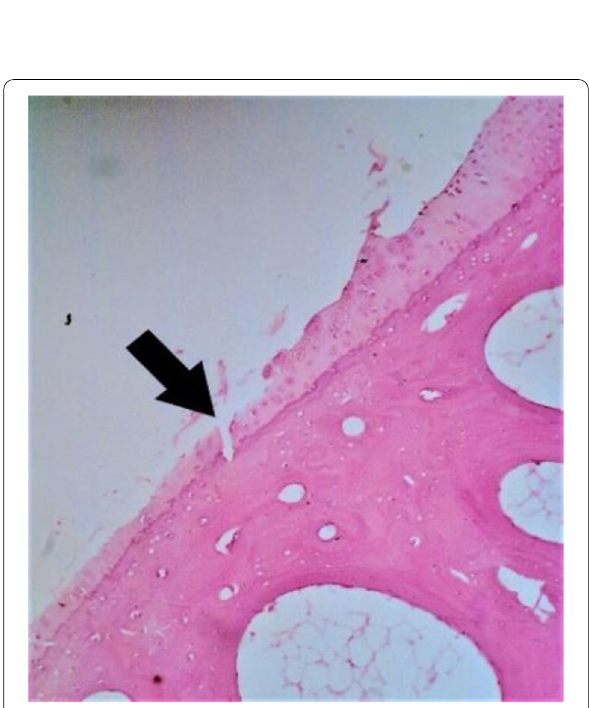
Fig. 2 Microscopic appearance in control group showing tear through the tidemark and large hypocellular area